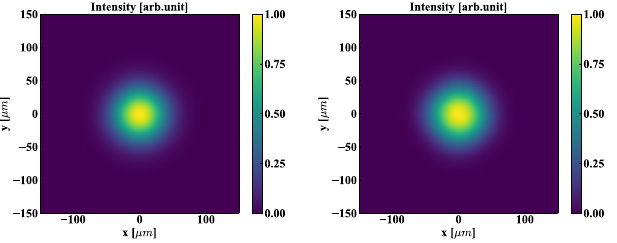
FIG. 4. The transverse radiation profiles of E H (left column) and E V (right column) are shown. It demonstrates that the output has a Gaussian mode.